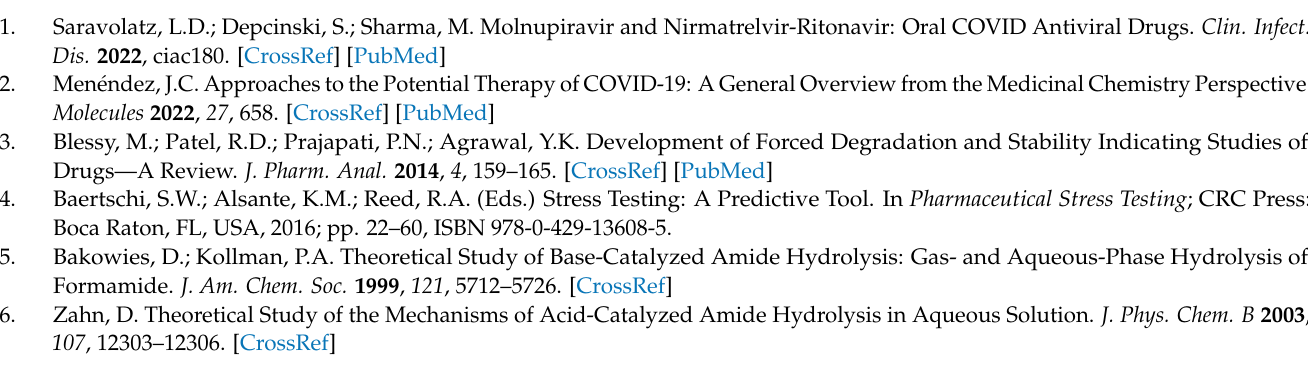
(a), Figure S2: LC-HRMS 2 mass spectrum of protonated nirmatrelvir, Figure S3: LC-HRMS 2 mass spectrum of protonated DP 517 , Figure S4: LC-HRMS3 mass spectrum of the ion of mass to charge ratio 501 obtained after fragmentation of protonated DP 517 , Figure S5: LC-HRMS 2 mass spectrum of protonated DP 403 , Figure S6: LC-HRMS 2 mass spectrum of protonated DP 421